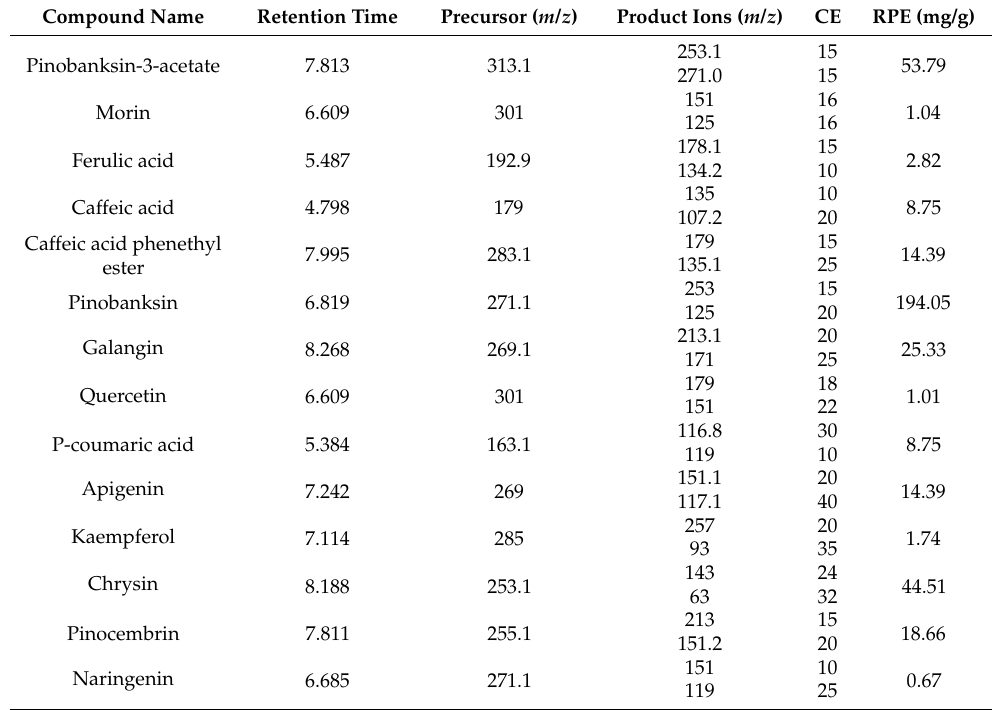
Table 1. Quantitative results for 14 polyphenols in